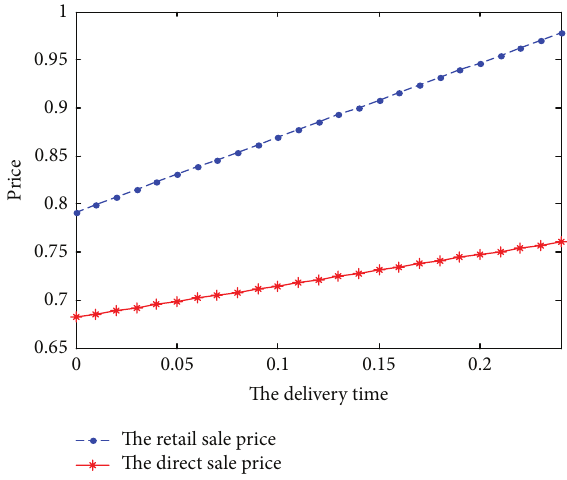
Figure 1: Effect of the delivery time on optimal prices of centralized supply chain.